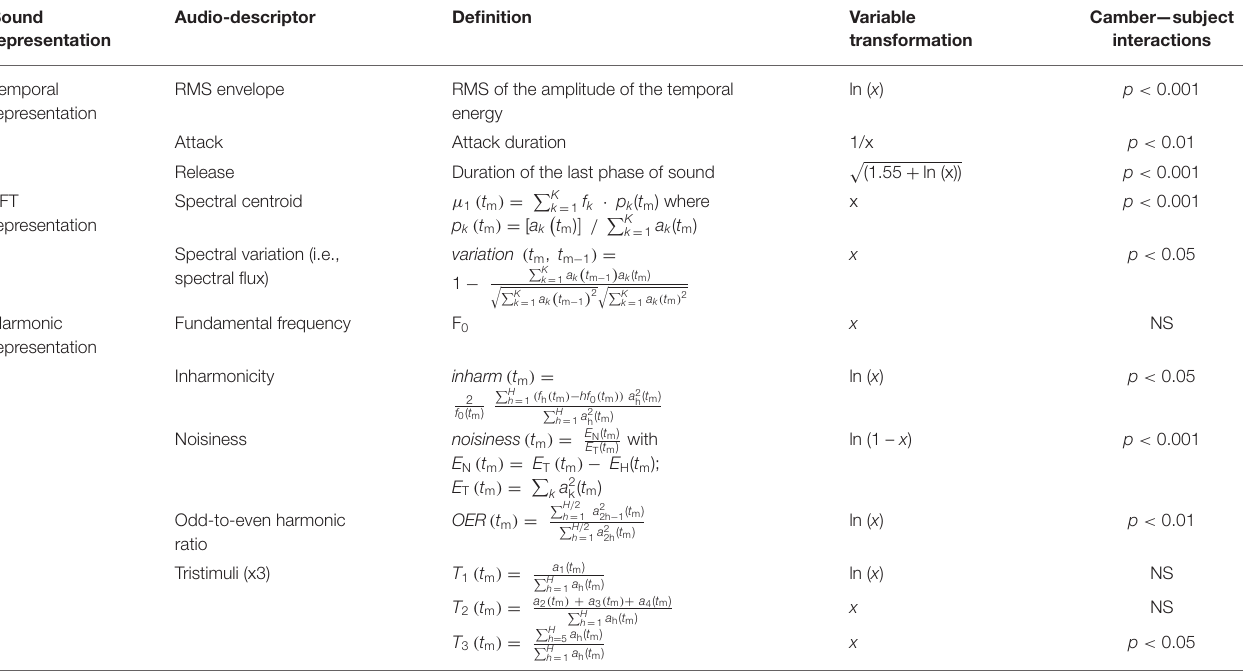
TABLE 1 | Main audio-descriptors as calculated in Peeters et al. (2011), variables transformed in our study, and camber-participant interaction effect on